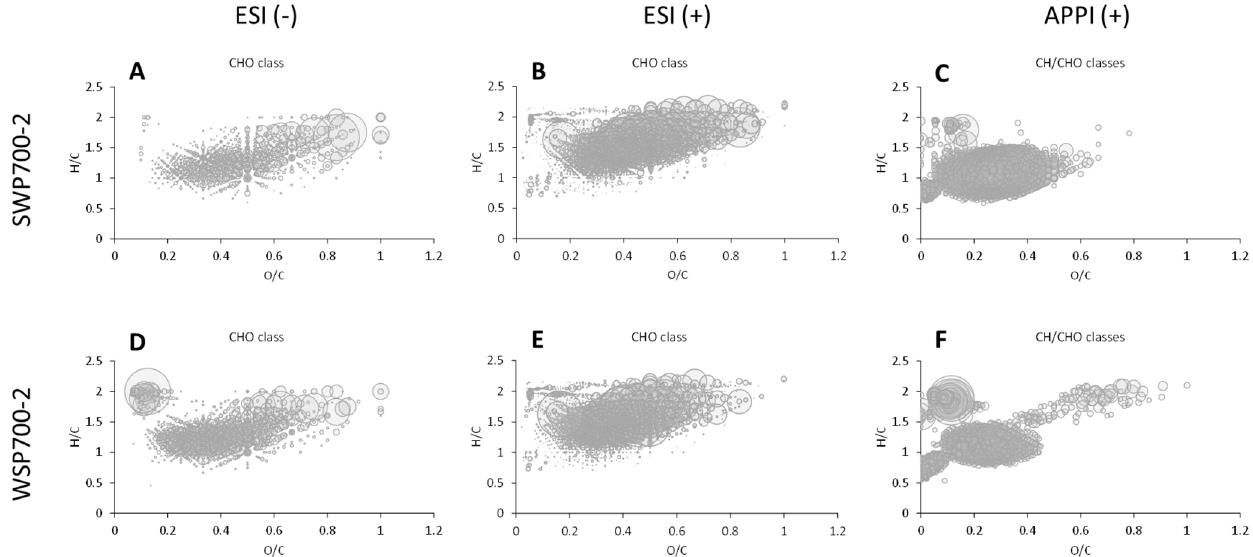
Figure 1. Van Krevelen diagrams of CxHyOz compounds assigned and detected by ESI (+/ − ) and APPI (+) FTICR MS in bio-oils from pyrolysis, at 700 °C, of soft wood pellets (SWP700-2) and wheat straw pellets (WSP700-2). ( A ) SWP in ESI ( − ); ( B ) SWP in ESI (+); ( C ) SWP in APPI (+); ( D ) WSP in ESI ( − ); ( E ) WSP in ESI (+); ( F ) WSP in APPI (+).